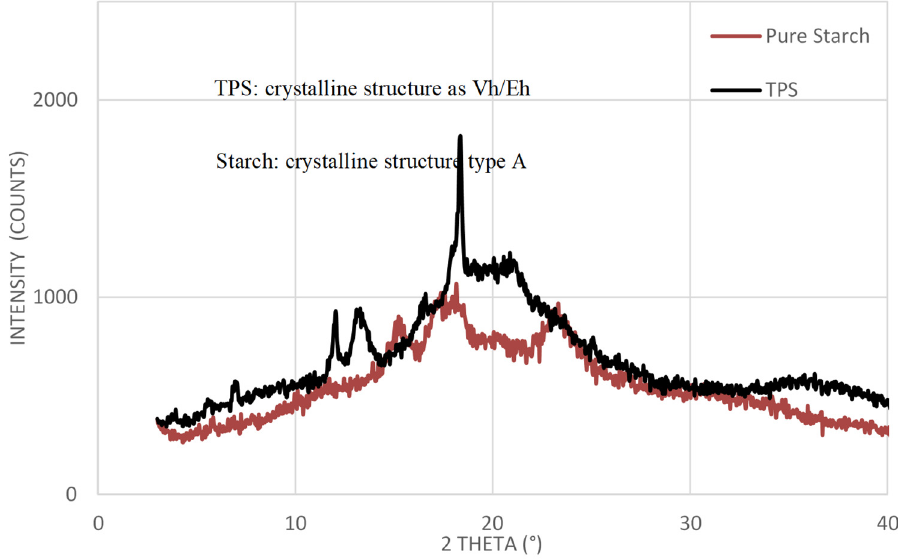
Figure 8. Standardized XRD spectrum of native starch and TPS plasticized starch.